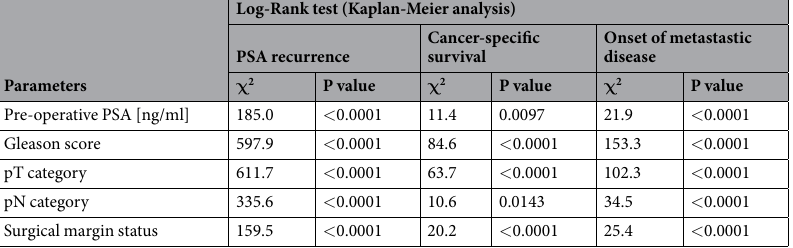
Table 2. Associations of pathological parameters of prostate cancers samples with time to biochemical (PSA) recurrence, onset of metastasis, and cancer-specific survival in patients after radical